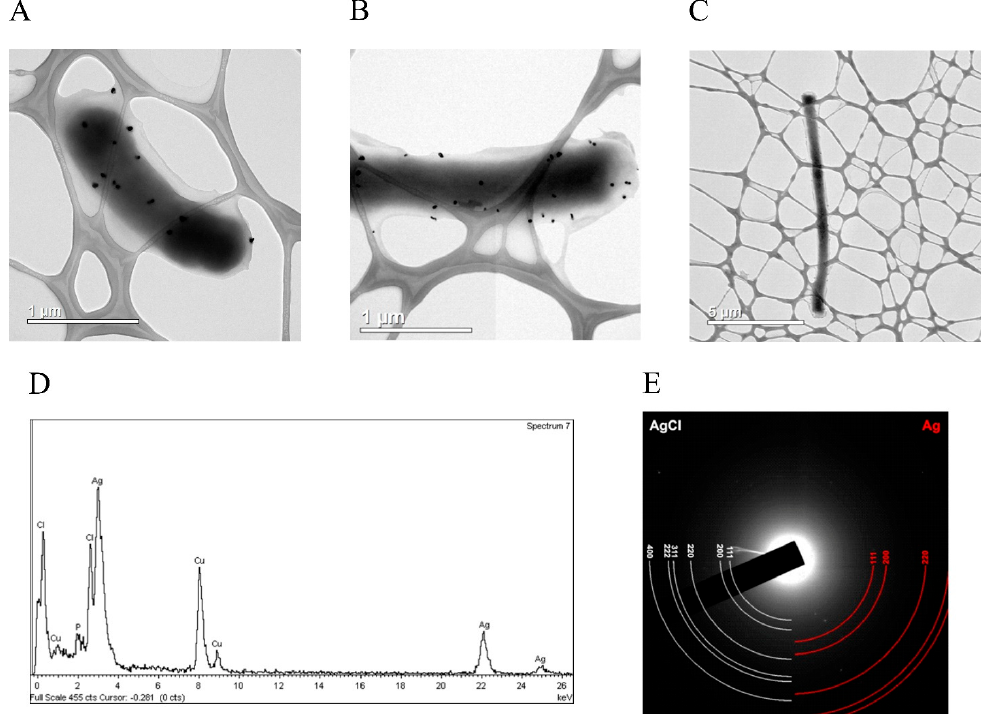
Figure 7. Typical TEM image of silver nitrate-treated E. coli cells expressing the fusion (GST- hNdCTR1) protein with AgCl aggregates ( A ) and with formed SNP ( B ). ( C ) Filamentous bacterium. ( D ) Characteristic EDS spectrum of the formed SNP. ( E ) Electron diffraction analysis of the formed